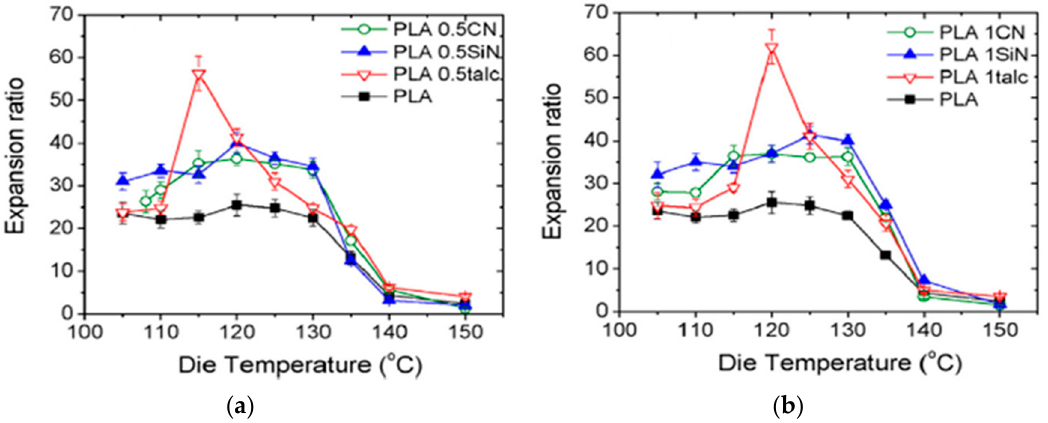
Figure 33. Expansion ratio of the foamed PLA and PLA/Clay, PLA/Silica and PLA/Talc composites at various die temperatures ( a ) Content of 0.5 wt% and ( b ) Content of 1 wt%. Reprinted from Nofar [113]. Copyright (2020), with permission from Elsevier.